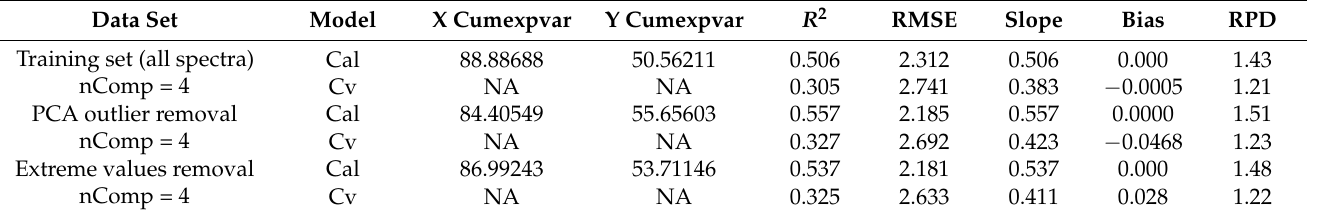
Table 2. PLS model summary for “hardness”